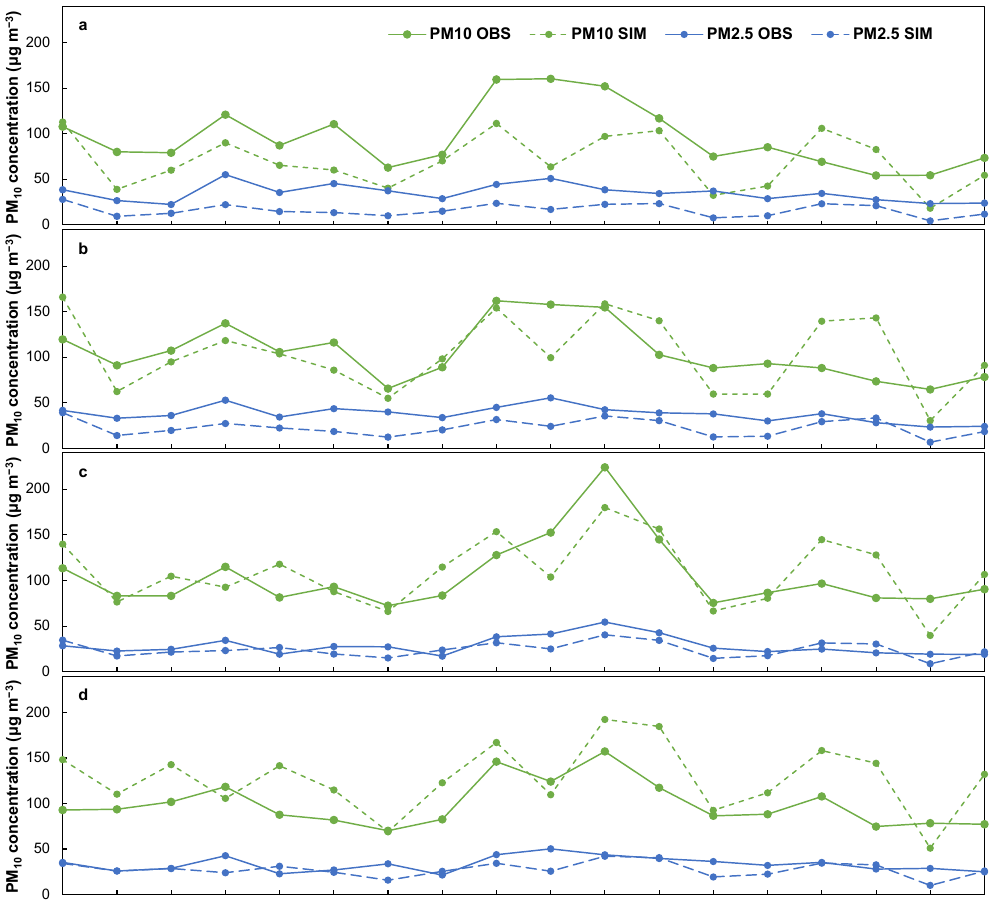
Figure 2. Comparison of monthly PM 10 and PM 2.5 concentrations between the spring simulations (SIM) and observations (OBS) from 2015 to 2020 in selected cities of Hohhot ( a ), Baotou ( b ), Erdos ( c ), and Yulin ( d ).